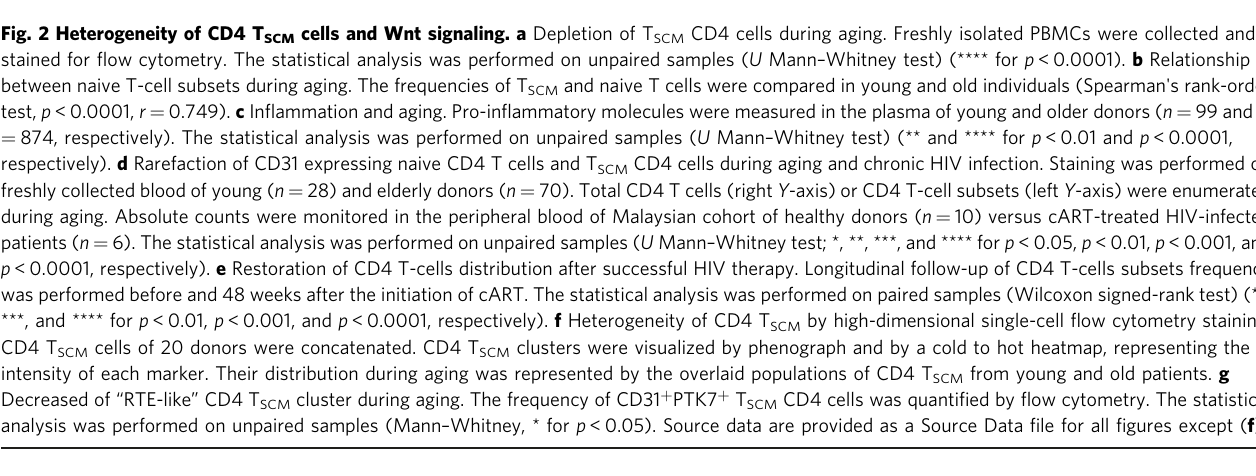
Fig. 2 Heterogeneity of CD4 T SCM cells and Wnt signaling. a Depletion of T SCM CD4 cells during aging. Freshly isolated PBMCs were collected